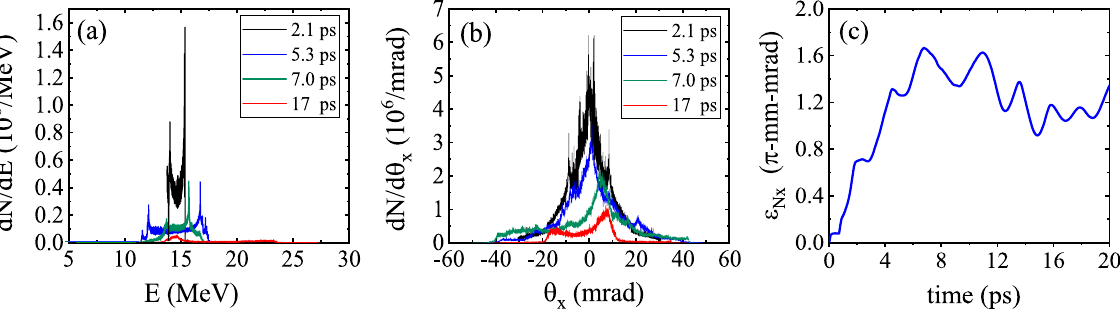
Figure 7. Plots showing how the (a) energy spectrum, (b) θ x distribution, and (c) emittance of the bunch change with